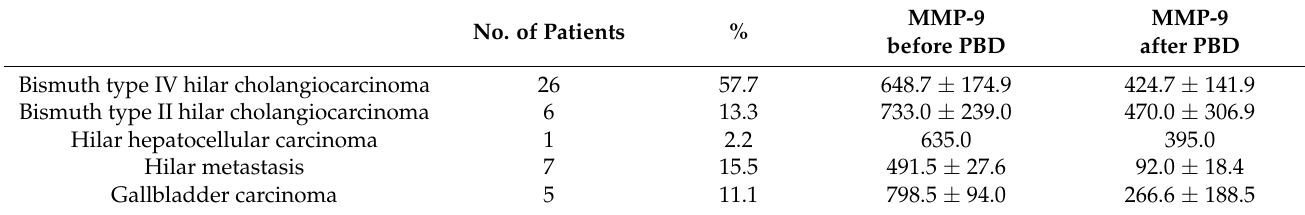
Table 1. Causes of malignant biliary